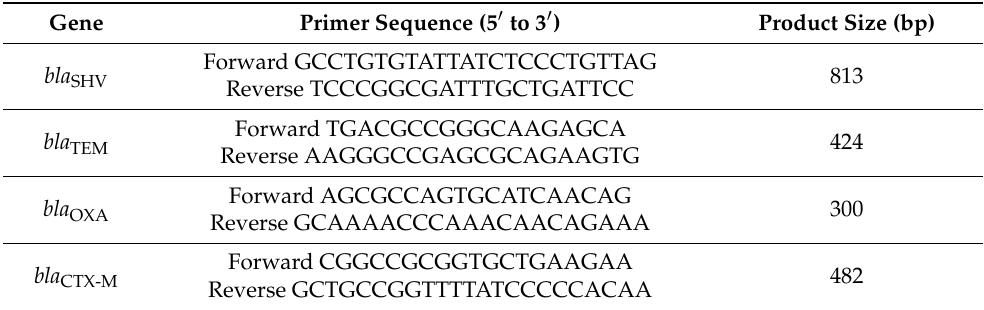
Table 6. List of primers pairs used to identify bla SHV , bla TEM , bla OXA , and bla CTX-M and their expected product